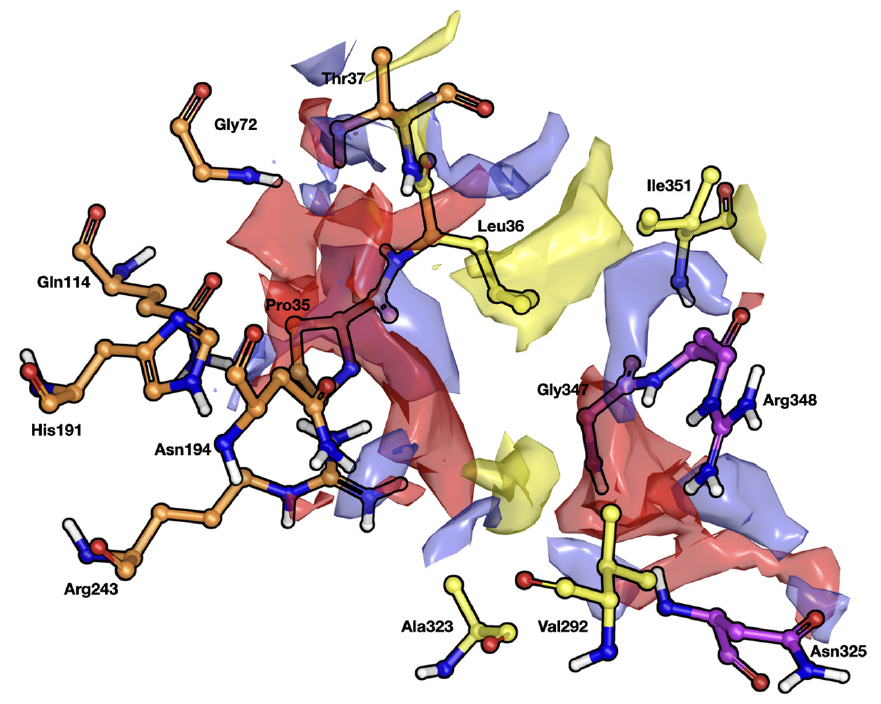
Figure 2. Binding site of Candida albicans NADPH dehydrogenase obtained using SiteMap. Residues forming region P1, H and P2 are represented in orange, yellow and purple, respectively. Surface color represents electronegative (red), electropositive (blue) or hydrophobic (yellow) regions.